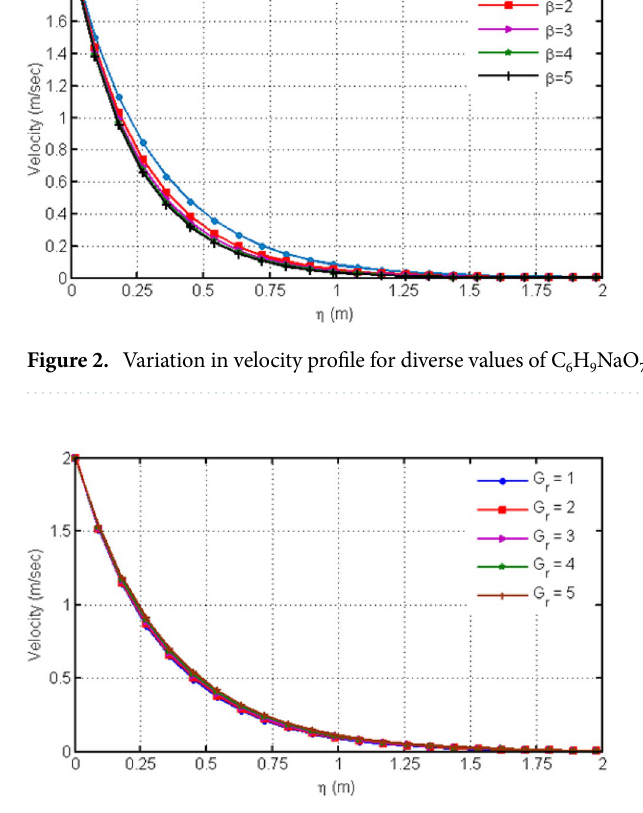
Figure 3. Variation in velocity profile for diverse values of Gr .